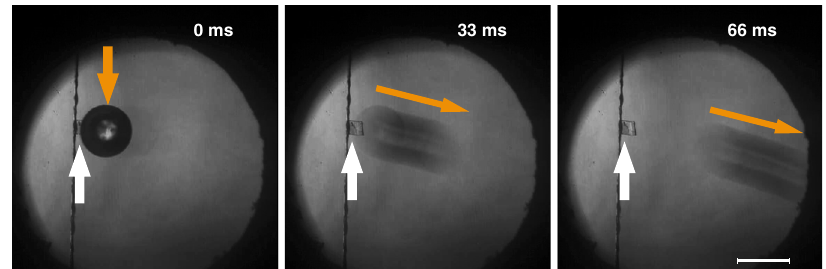
Fig. 5 Glass bead displacement by crystal deformation. The force generated by the shape deformation was evaluated by the displacement of a 0.15 mg glass bead. White arrows highlight the position of the organic crystal, while orange ones mark the position of the bead at 0 ms and the direction of the bead movement at 33 and 66 ms, respectively. These pictures were extracted from the Supplementary Video 3. Scale bar is 0.5